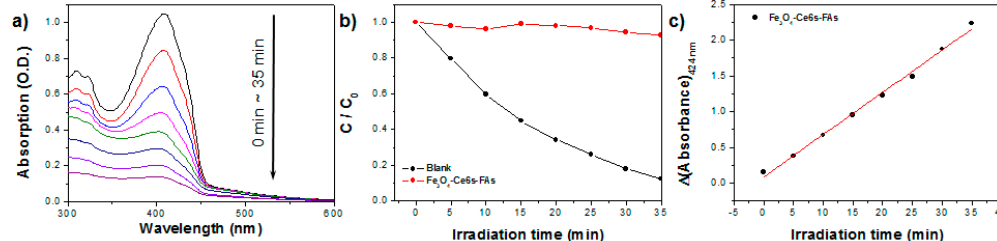
Figure 3. ( a ) UV-Vis spectra of 1,3-diphenylisobenzofuran (DPBF) in ethanol with the chlorin e6- and folic acid-conjugated magnetite (Fe 3 O 4 -Ce6-FA) nanoparticles in accordance with the irradiation time with a red LED lamp ( λ max = 660 nm); ( b ) The kinetic curve of the photodegradation efficiency of DPBF